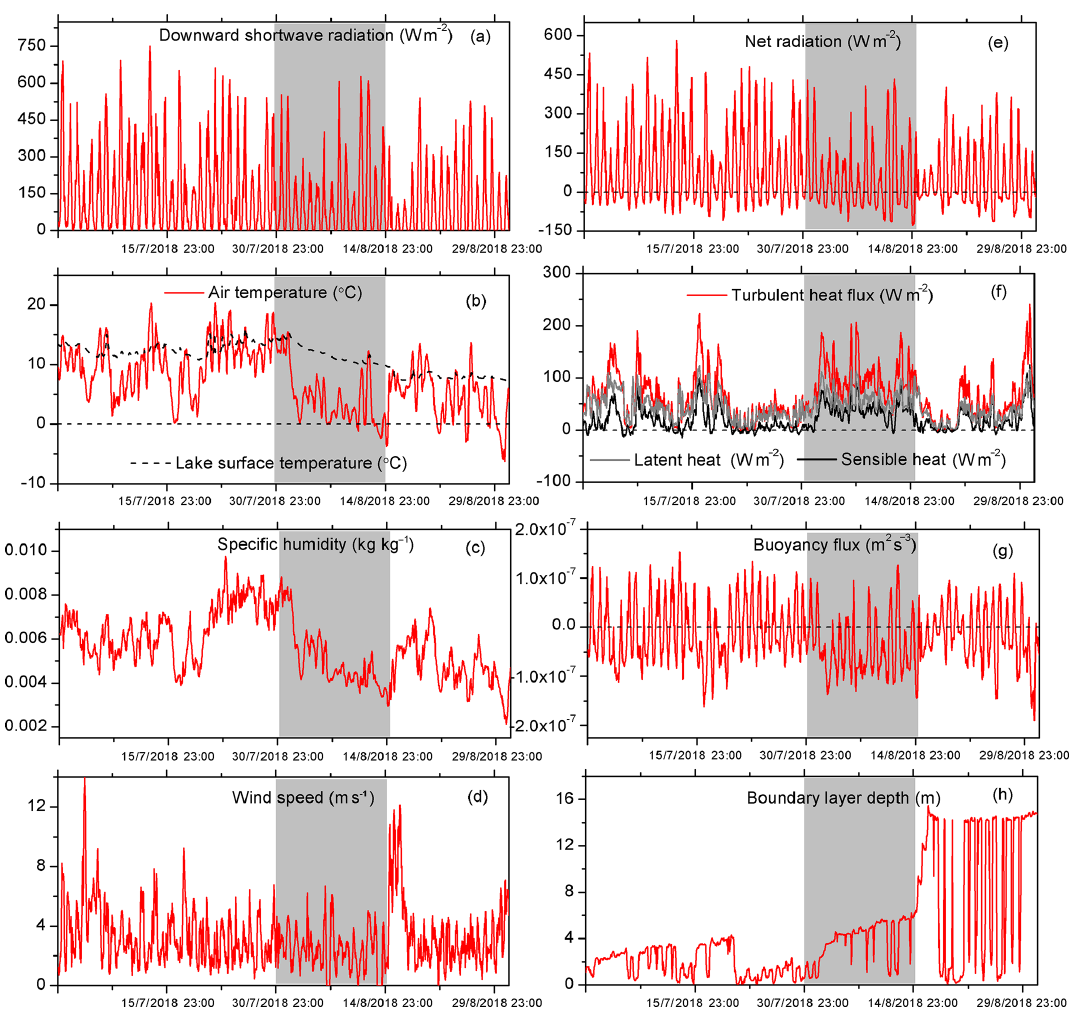
Figure 6. Time series of (a) observed downward shortwave radiation (Wm − 2 ), (b) observed air temperature and WST ( ◦ C), (c) observed specific humidity (kgkg − 1 ), (d) observed wind speed (ms − 1 ), (e) simulated net radiation (Wm − 2 ), (f) simulated turbulent heat flux (Wm − 2 ) (red line) with latent heat flux (gray line) and sensible heat flux (black line), (g) simulated buoyancy flux (m 2 s − 3 ), and (h) simulated boundary layer depth (m). The gray shading covers 1 through 15 August. The simulations were from